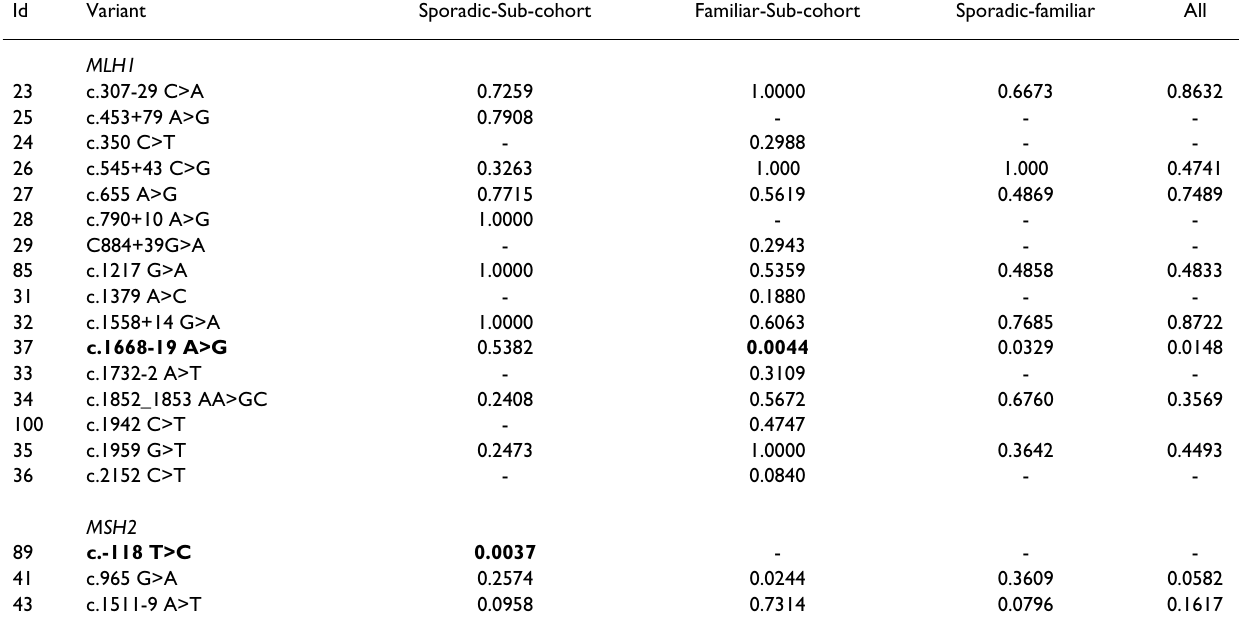
Table 4: The p -values of marginal Fisher's exact tests between groups Id